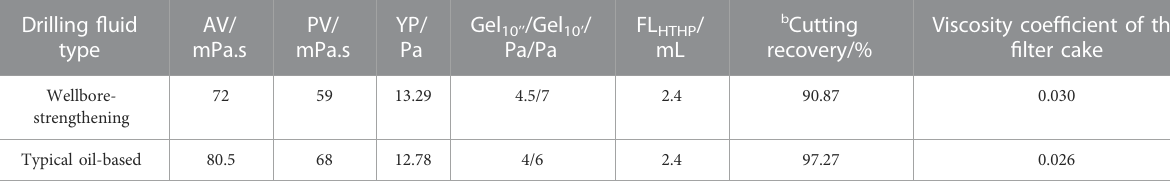
Wellbore- strengthening